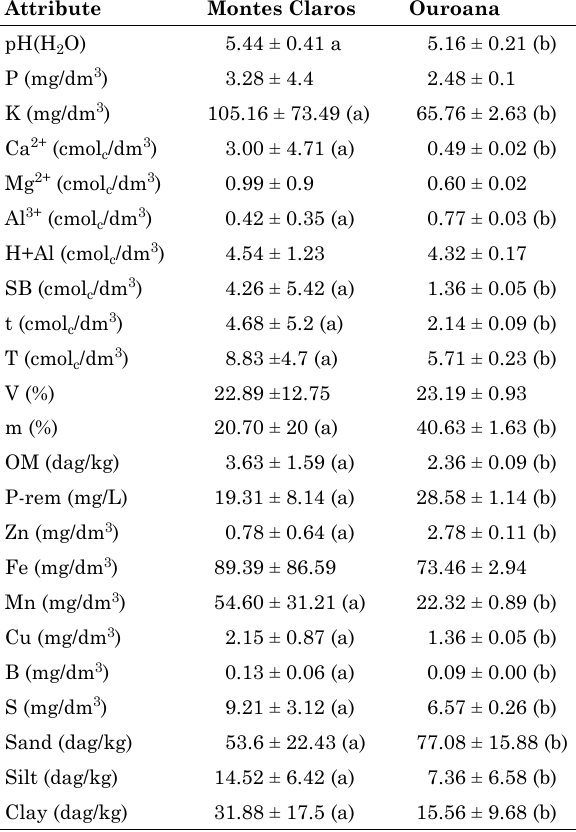
Table 2. Chemical and physical soil properties of the superficial soil layer (0-20 cm depth) sampled from cerrado fragments in southeastern goiás, brazil